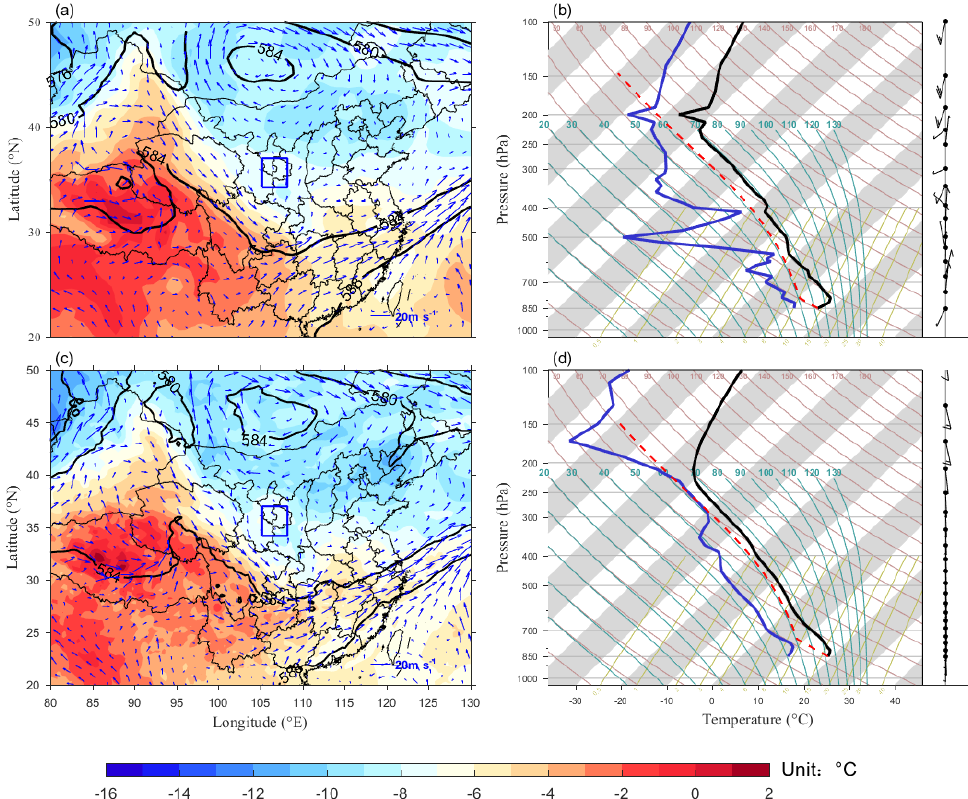
Figure 2. ( a ) Composite map of geopotential height (black contours, units: gpm), temperature (shaded, units: ◦ C), and wind vectors (blue vectors, units: m s − 1 ) at 0700 LST at 500 hPa from ERA-interim and ( b ) observed radiosonde soundings at 0700 LST at Pingliang on 29 June 2017, black and blue solid lines denote temperature (units: ◦ C) and dew-point temperature (units: ◦ C), respectively, and red dotted line represents the air mass curve. The long and short bars on the right-hand denote 10 m s − 1 and 5 m s − 1 , respectively, ( c ) same as ( a ) but from the WRF simulation, ( d ) same as ( b ) but from the WRF simulation.